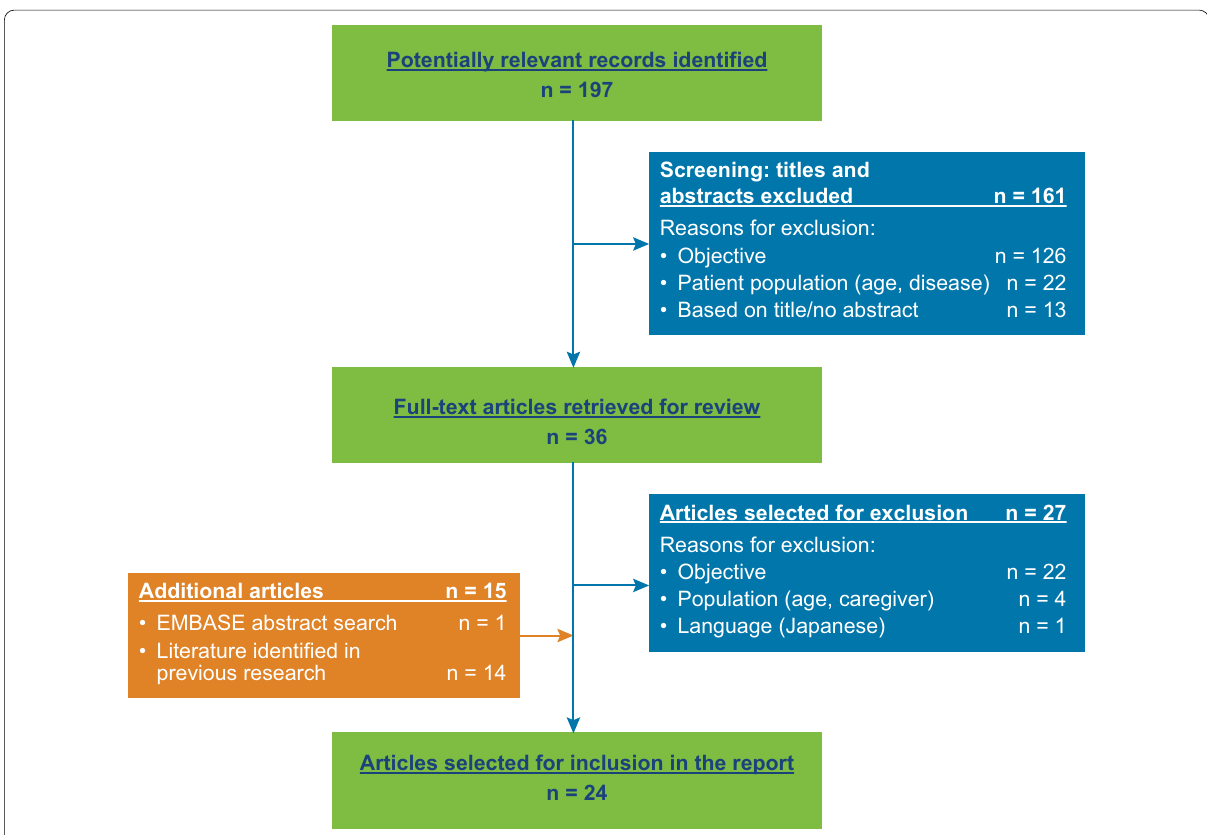
Fig. 1 Flow diagram for included and excluded